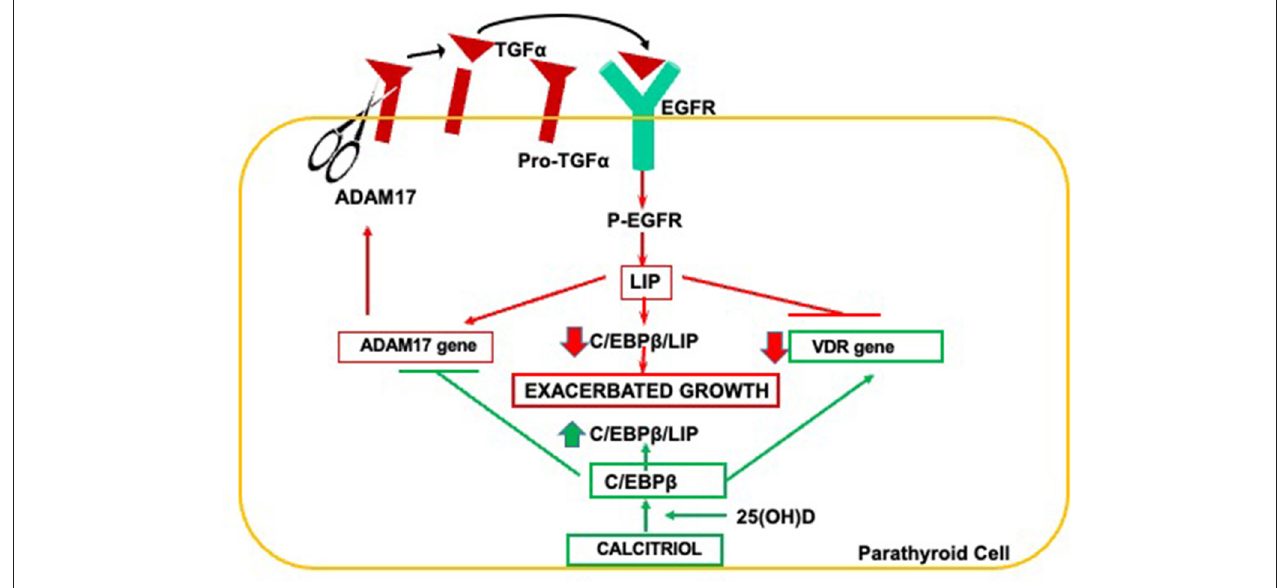
FIGURE 2 | Pathogenesis of parathyroid hyperplasia and resistance to calcitriol actions in CKD. Increases in ADAM17 release of TGF α initiate a vicious ADAM17/TGF α -EGFR cycle responsible for elevations in LIP, the dominant negative isoform of C/EBP β . Reductions in parathyroid C/EBP β /LIP ratio induce the ADAM17 gene and suppress VDR gene expression exacerbating parathyroid growth and creating resistance to calcitriol actions. Synergistic interactions between 25(OH)D and calcitriol induce C/EBP β expression to safely counteract both exacerbated growth and VDR